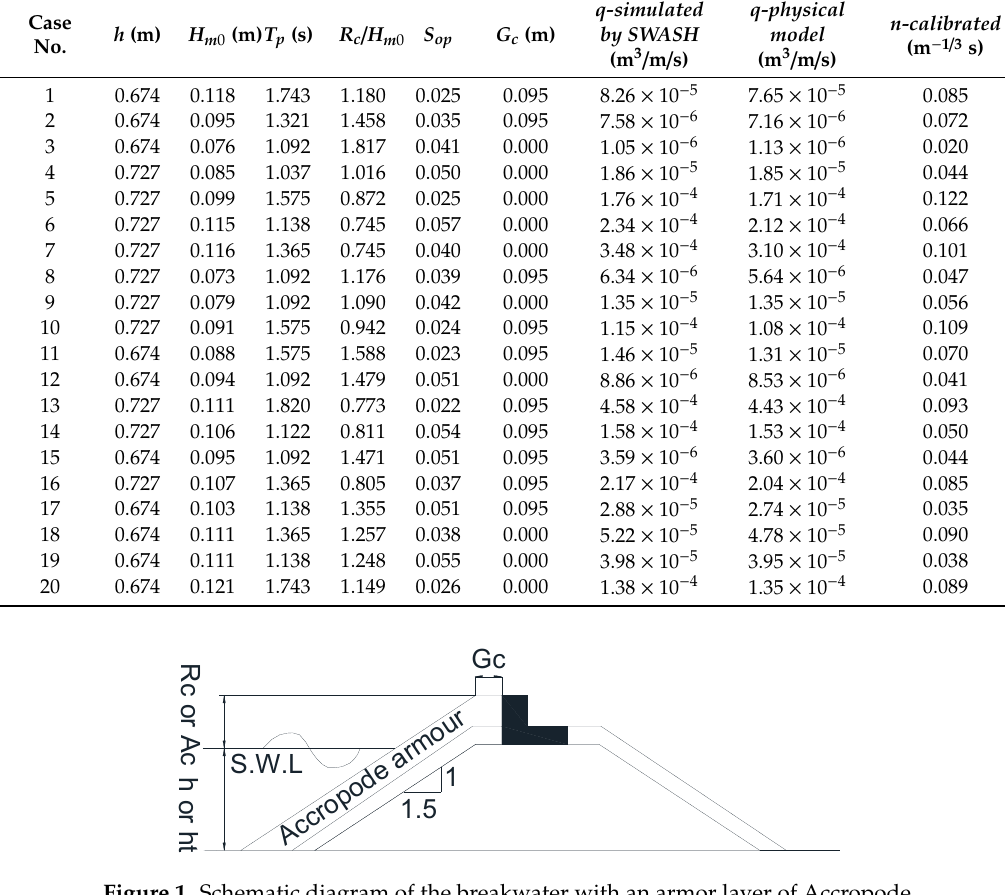
Figure 2. The time series of wave overtopping simulated by the SWASH model. ( a ), ( b ) and ( c ) represent Case 13, Case 14 and Case 15 in Table 1, respectively. 4. Influencing Factors of Equivalent Roughness Coefficient Section 3 shows that the wave overtopping of the Accropode armored breakwater can be accurately simulated by the SWASH model through the appropriate apparent friction coefficient f c (or Manning’s coefficient n ). In this section, we try to find the factors that affect the apparent friction coefficient. It provides a basis for fitting the empirical formula. To obtain the